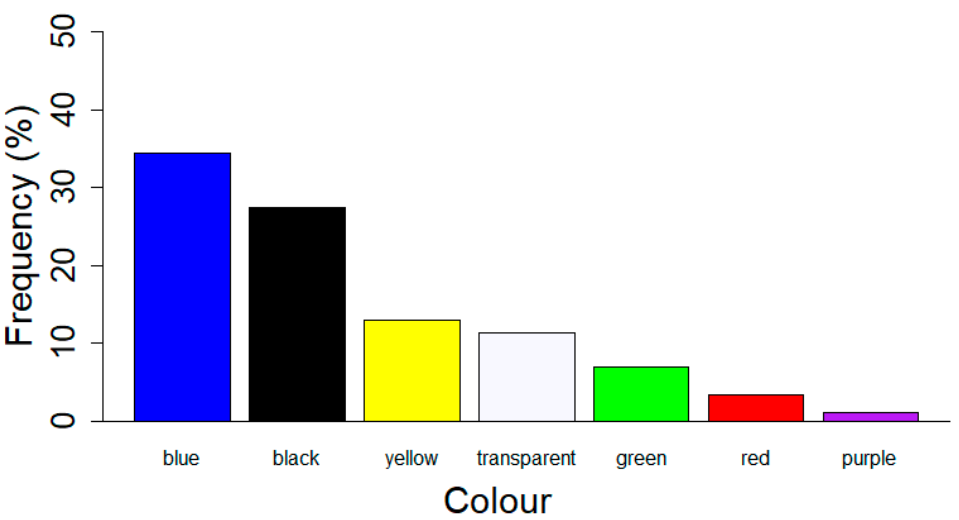
Figure 3. Colours of MPs found expressed as the frequency of occurrence in the entire dataset. Only colours with a proportion higher than 1% are shown.